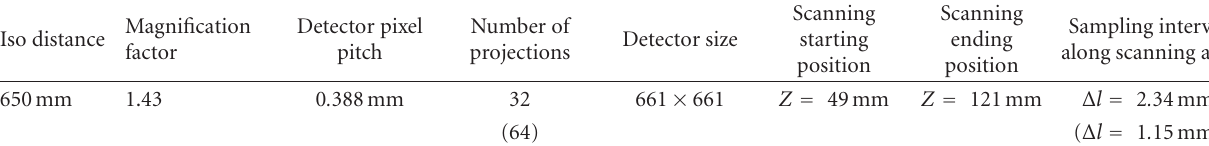
Table 1: Partial helical scan parameters.